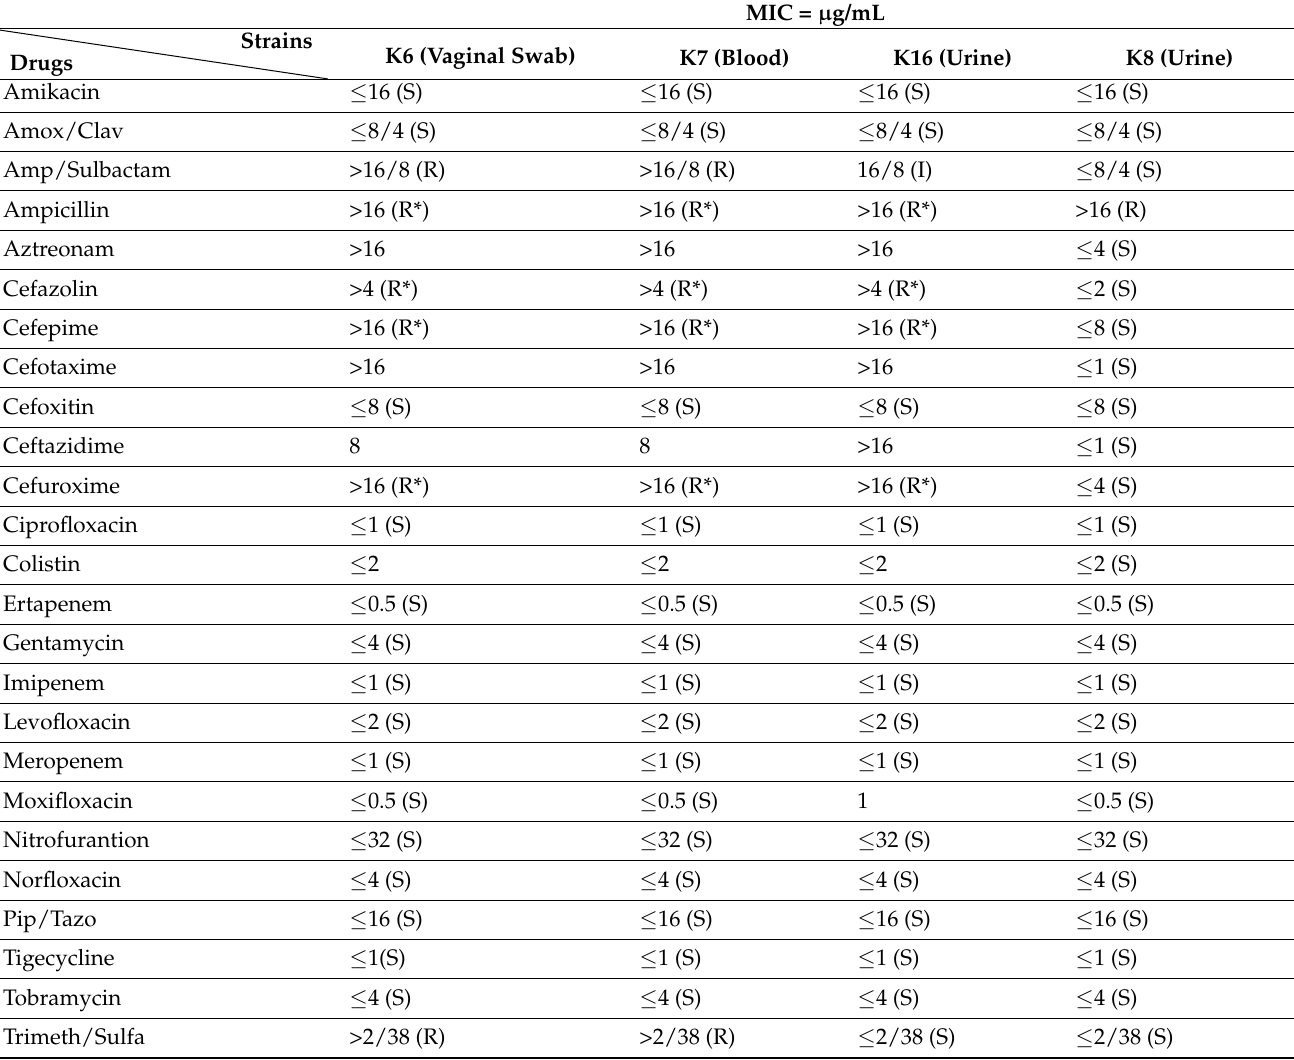
Table 1. MIC and antimicrobial susceptibility profile for isolated strains of